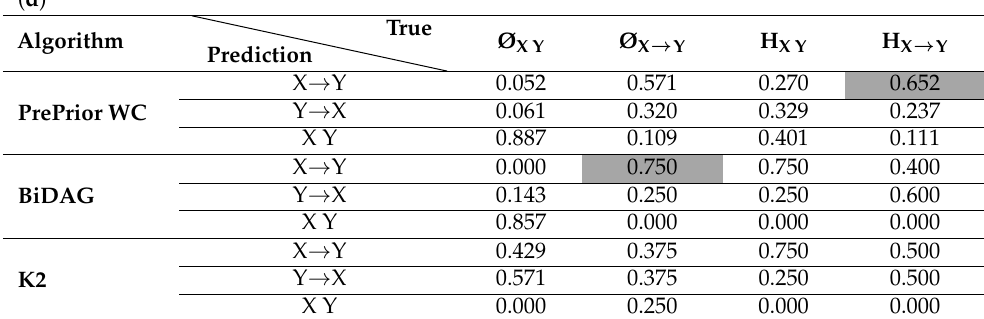
Table 9. Algorithms’ predicted probabilities of four causal pairwise relationships with the order weight. (a) Dataset for Sparse 9 variable with 50 cases (D50S9). Dark shaded cells represent the best prediction of the correct causal relationship; Bright shaded cells represent the second best prediction of the correct causal relationship. (b) Dataset for Close 9 variable with 50 cases (D50C9). Dark shaded cells represent the best prediction of the correct causal relationship; Bright shaded cells represent the second best prediction of the correct causal relationship. (c) Dataset for Sparse 9 variable with 1000 cases (D1KS9). Dark shaded cells represent the best prediction of the correct causal relationship; Bright shaded cells represent the second best prediction of the correct causal relationship. (d) Dataset for Close 9 variable with 1000 cases (D1KC9). Dark shaded cells represent the best prediction of the correct causal relationship; Bright shaded cells represent the second best prediction of the correct causal relationship.